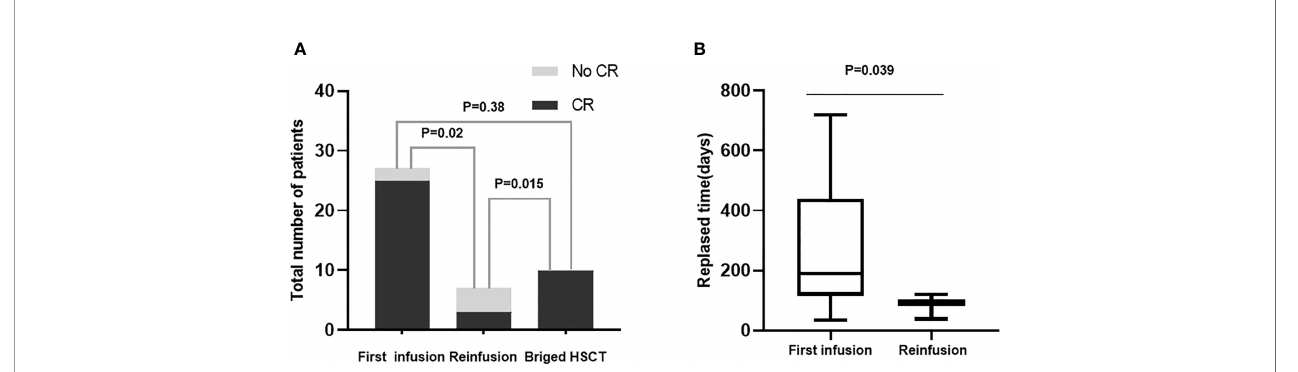
FIGURE 1 | (A) The in fl uence of different times of infusion and receving allo-HSCT on CR rate. First infusion (n = 27); Reinfusion (n = 7); Bridge HSCT (n = 10). (B) The relapsed days according to times of infusion. First infusion (n = 14); Reinfusion (n = 3).